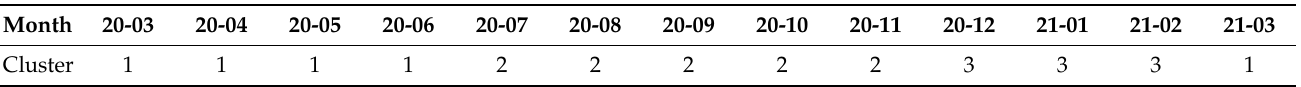
Table 10. Membership of the listed cluster for the number of COVID-19 infected cases in the indicated month using the k-means